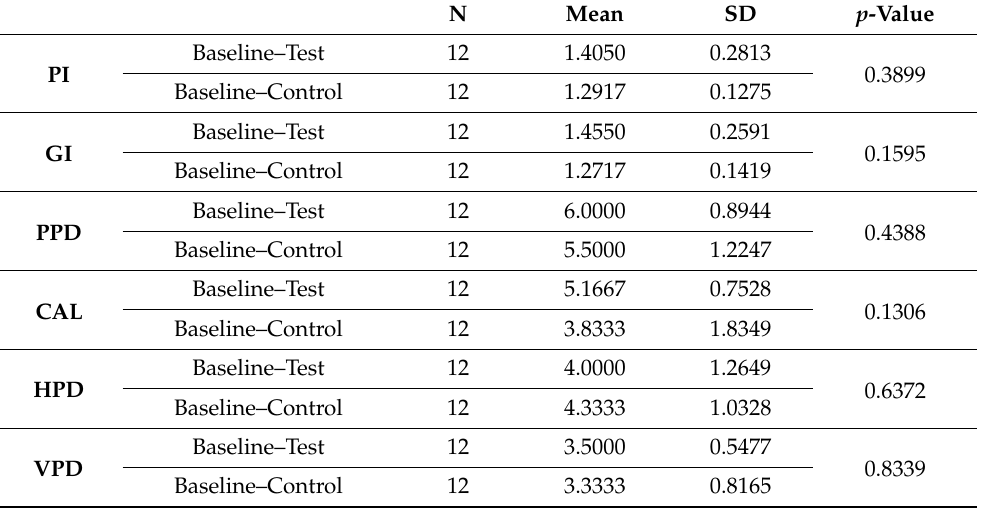
Table 2. Comparison of mean scores between test and control groups at baseline for various clinical parameters by independent t